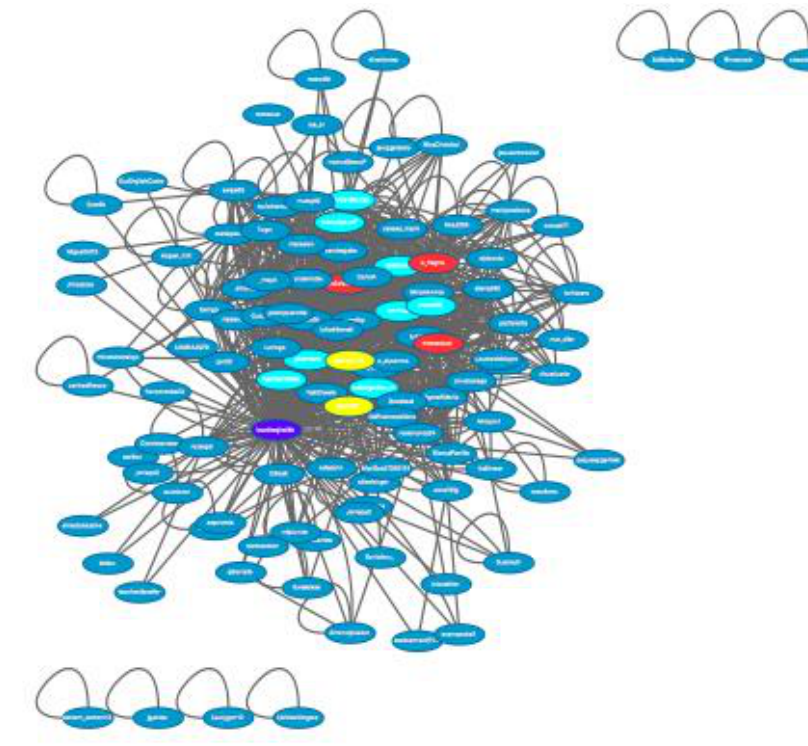
Figure 11 . Representation of the Books conversational network